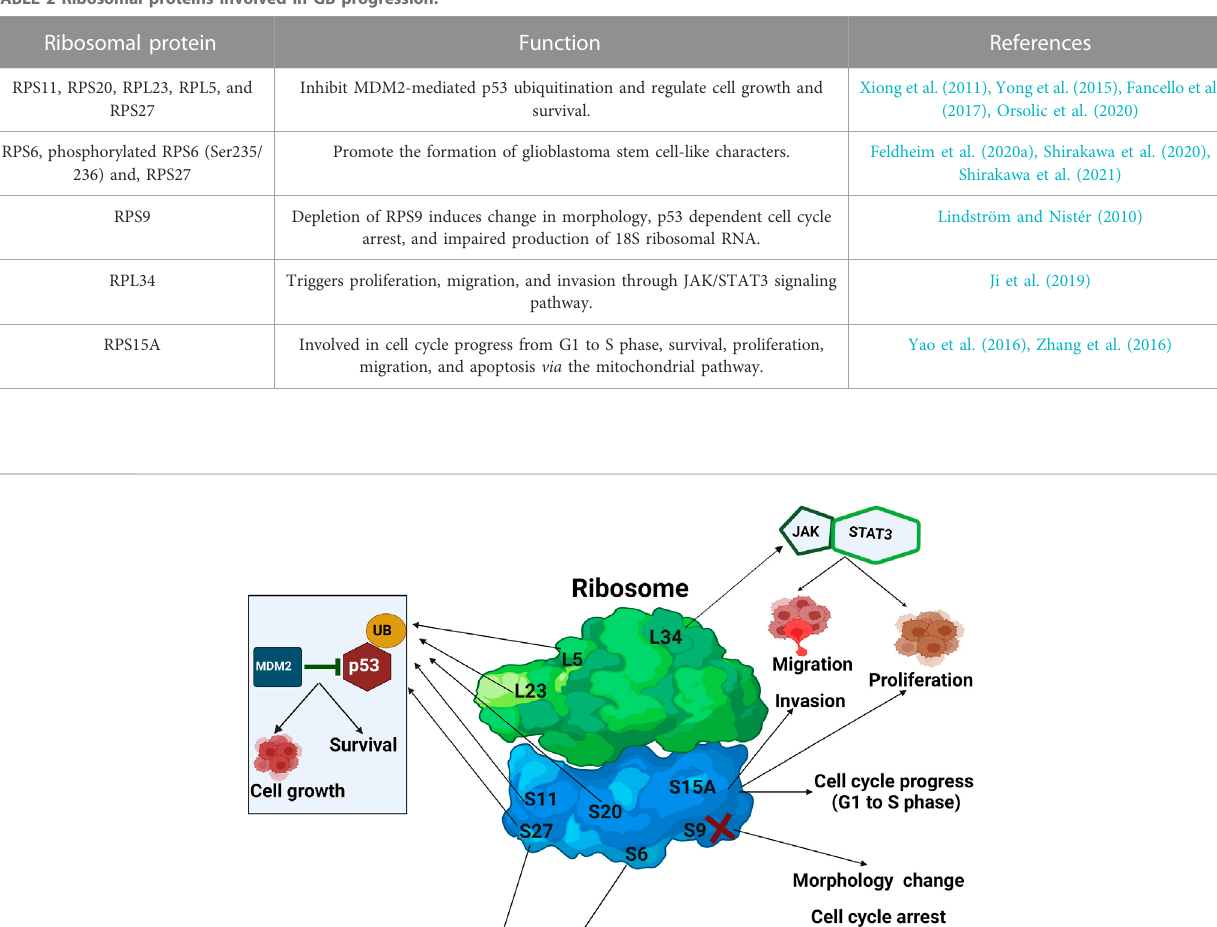
Frontiers in Cell and Developmental